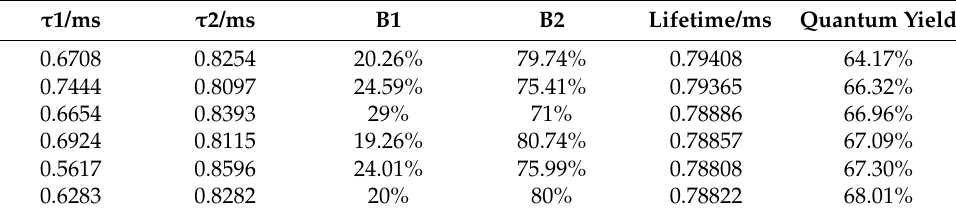
Table 2. Fluorescence lifetime parameters and absolute quantum yield.